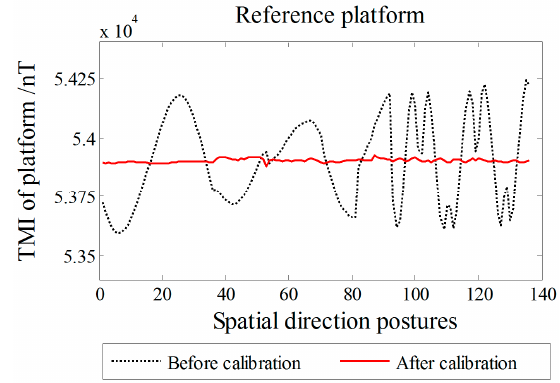
Figure 8. Artificial reference platform output before and after calibration.